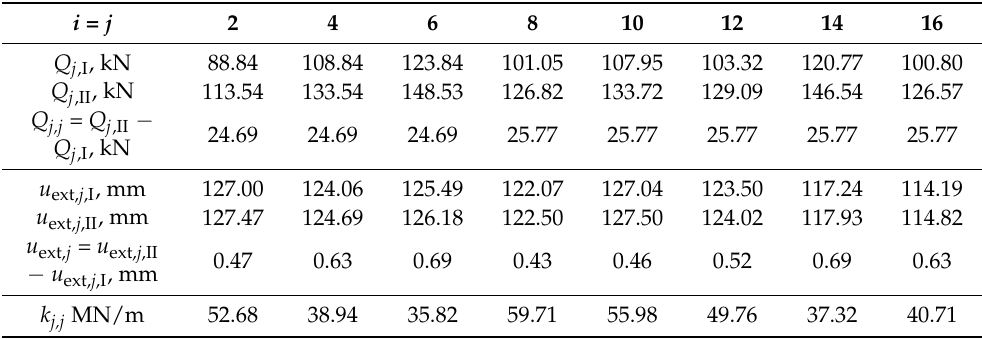
Table A3. Stiffness k j,j determined from in-situ tests according to (1) at points at mid-points of the sides.